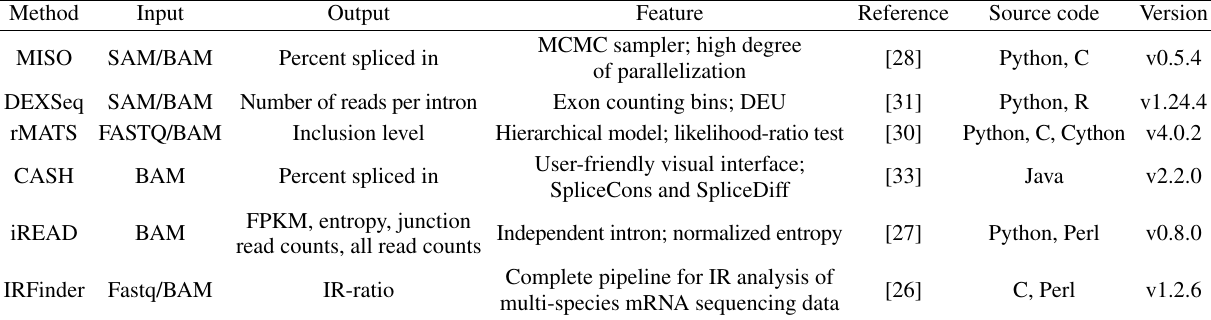
Table 1 Summary description of IR detection